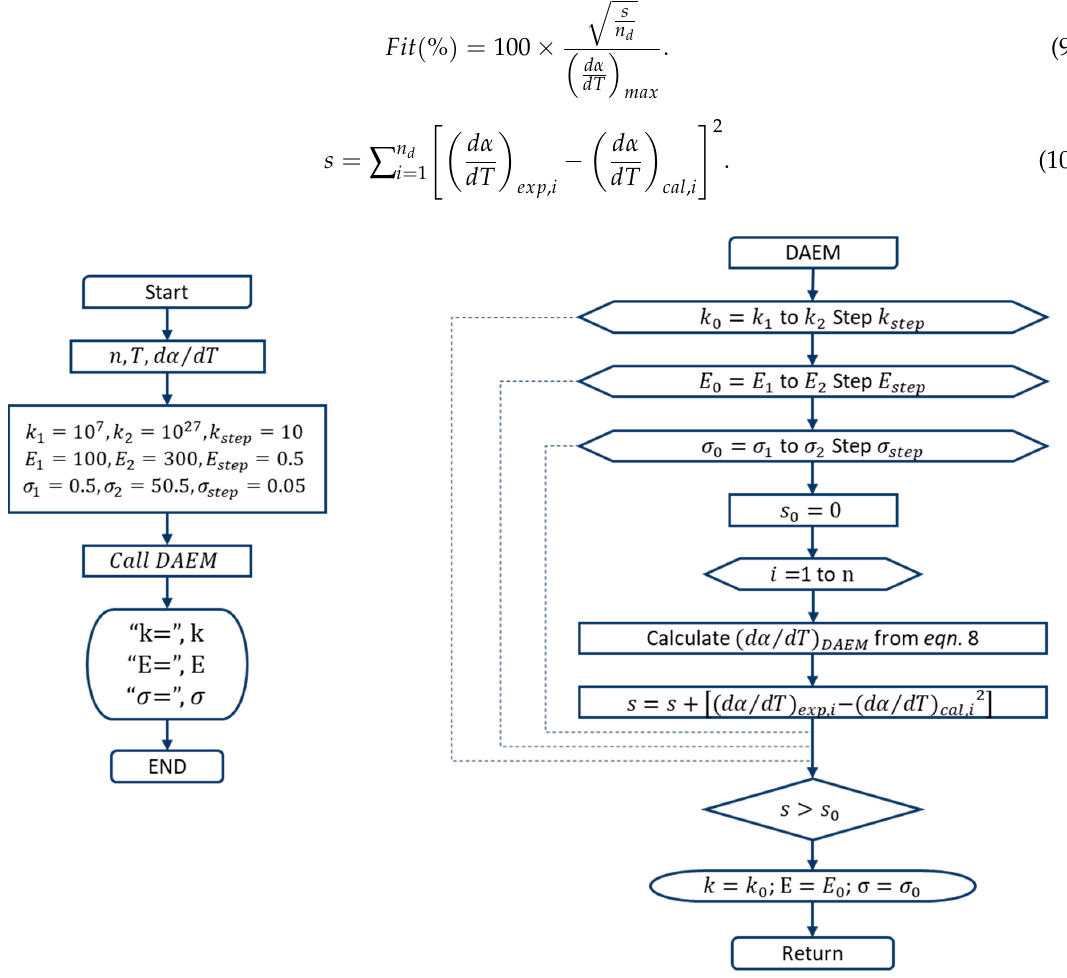
Figure 2. Distributed activation energy model ( DAEM) calculation algorithm.